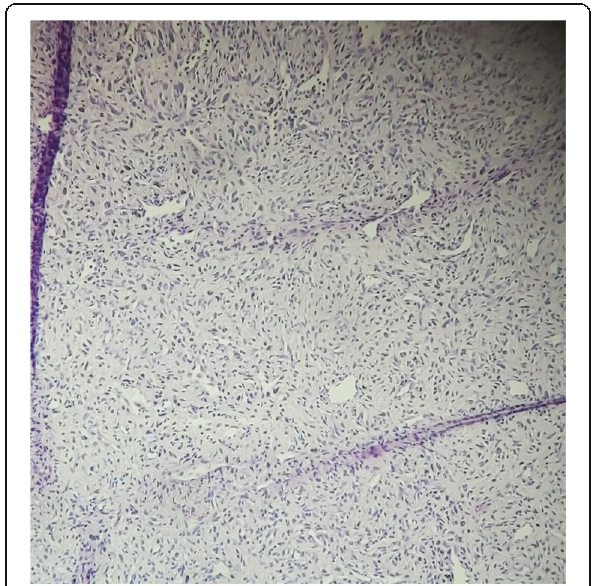
Fig. 1 Mesenchymal proliferation with a neurogenic